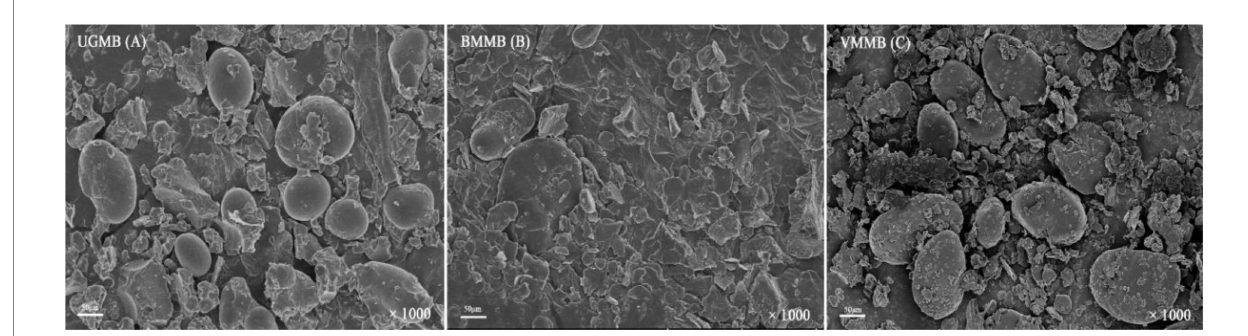
FIGURE 1 Scanning electron micrographs of different mung bean flour UGMB (A) ; BMMB (B) ; VMMB (C)